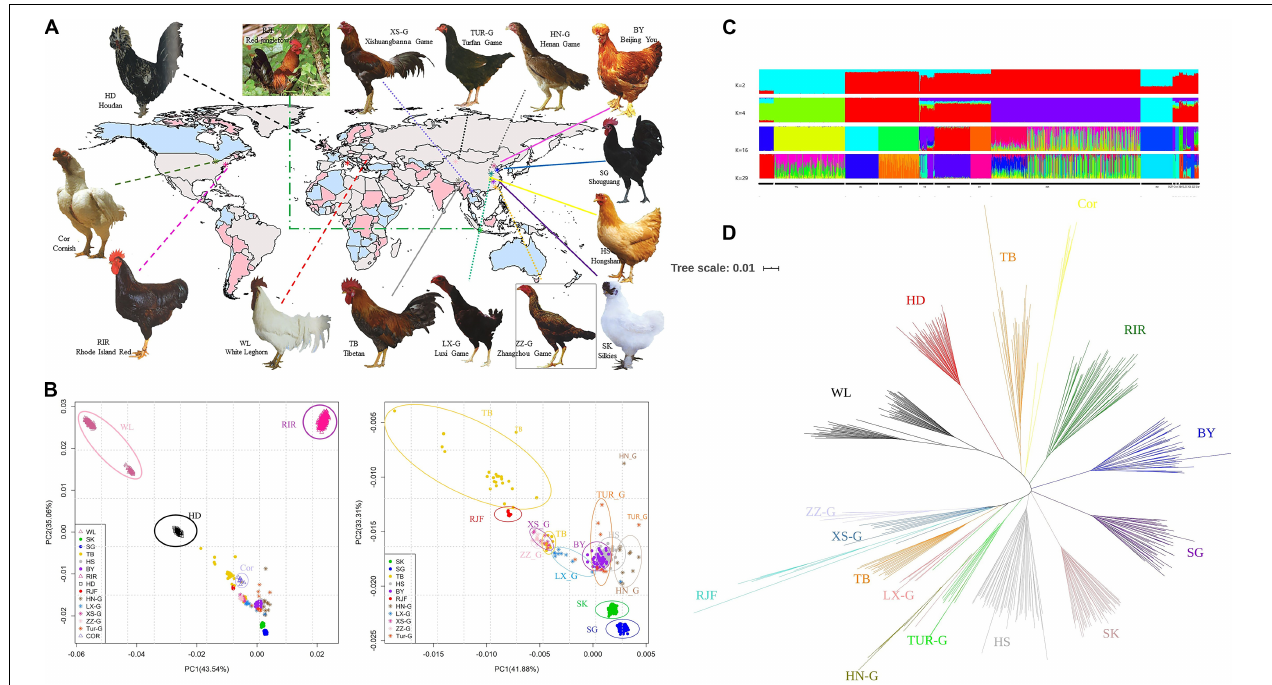
FIGURE 1 | (A) Chicken breeds with distinct phenotypes and geographical information (Photos came from poultry genetic resources in china). (B) Principal component analysis revealing genetic differentiation of 15 populations using SNP data. Breeds which are labeled, their names are mentioned in the main text; The Commercial breeds are denoted by triangle symbols, The Chinese indigenous breeds are displayed as dots, RJFs are displayed as plus sign, Europe local breed is denoted by squares, and the rest populations are marked as asterisks; PCA was performed on the whole population, plotting the first and the second dimension revealed PCA of 15 populations. (C) The admixture plot for breeds analyzed based on different number of assumed ancestors (K). (D) Neighbor-joining tree constructed using